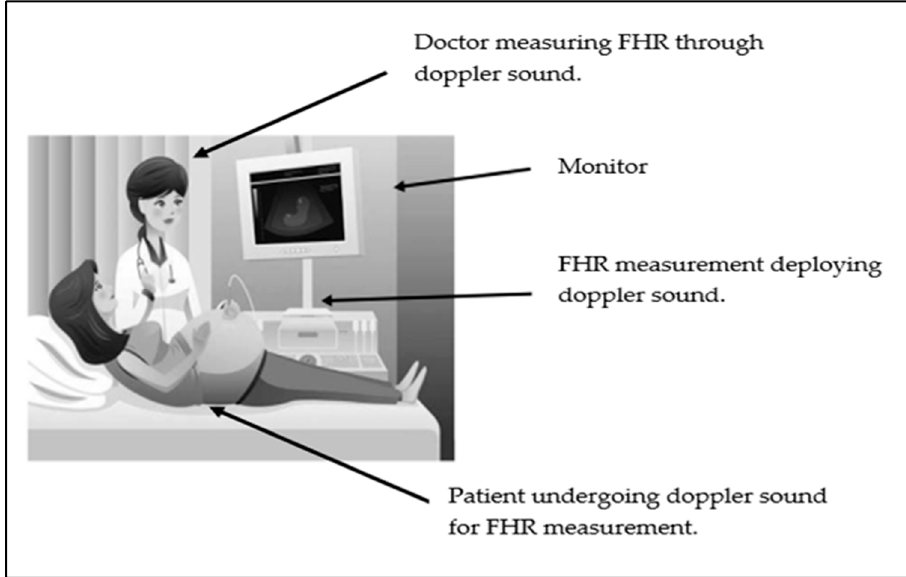
Figure 6. An illustration of the Doppler sound procedure for FHR monitoring.